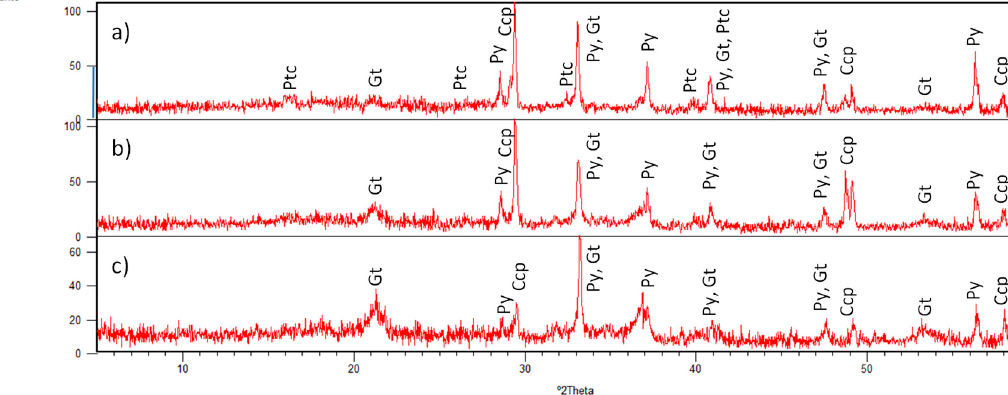
Figure 8. XRD patterns of GC-702 sediment samples: ( a ) A-20, ( b ) A-30 and ( c ) A-53. (For mineral name abbreviations and d-spacing labeled as a plane direction of h k l , see Table 2).